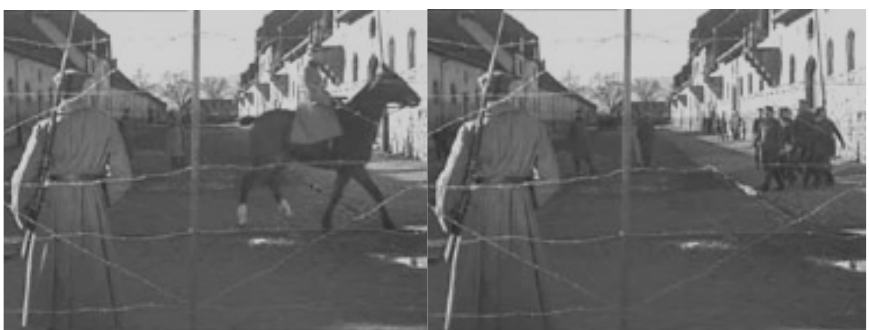
Figure 6-7 Le Grande Illusion . Director: Jean Renoir